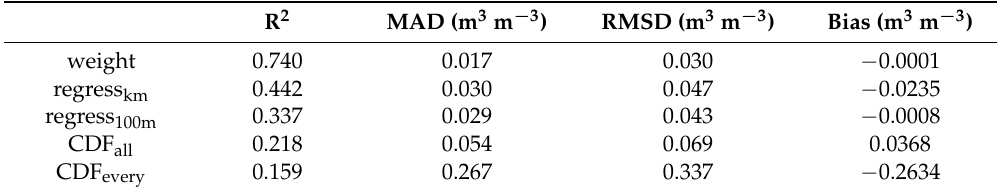
Table 3. Statistical evaluation of the concurrence between 100 m resolution disaggregated and DISPATCH products after masking out pixels of vegetated areas.